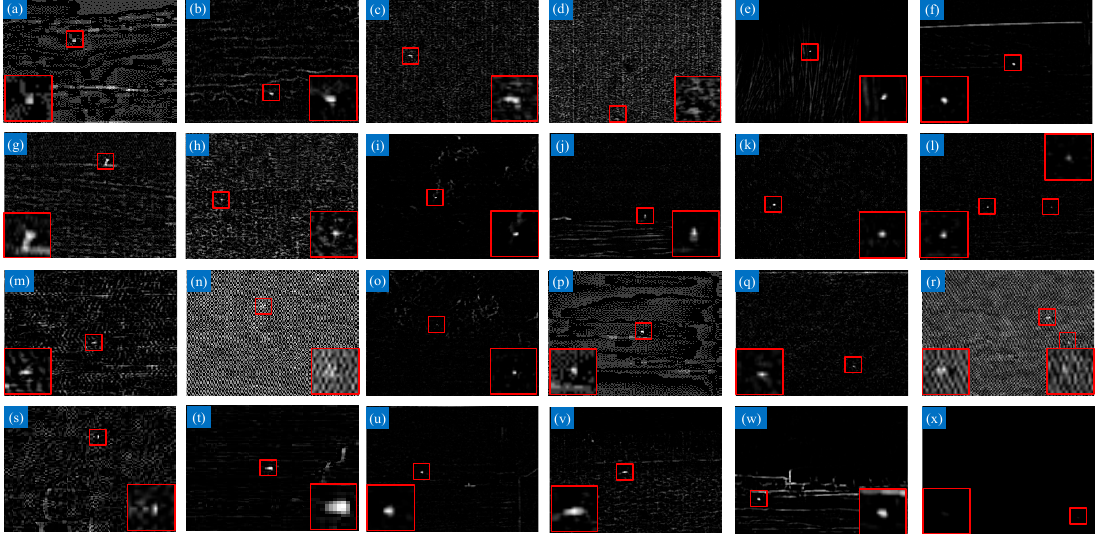
(x) Figure A3. The separated target images of MPCM under 24 scenes.